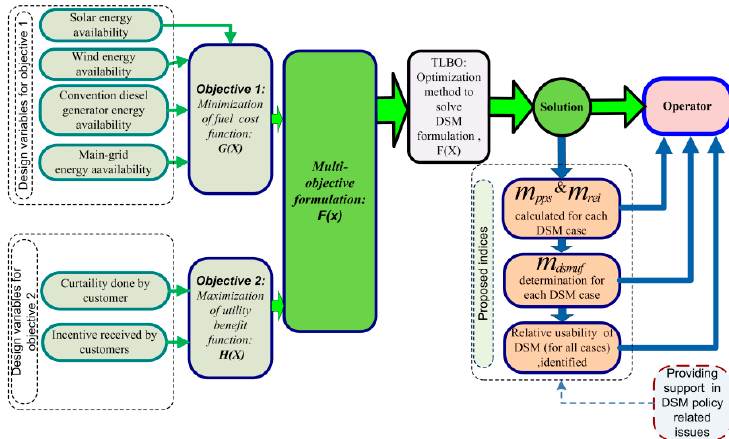
Figure 9. Schematic of the proposed indices application in a grid-tied microgrid.